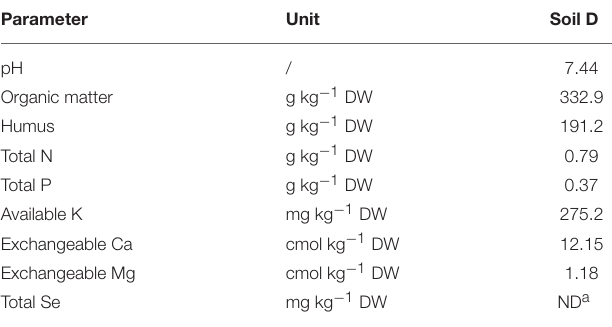
TABLE 1 | Parameters of the soil used in the